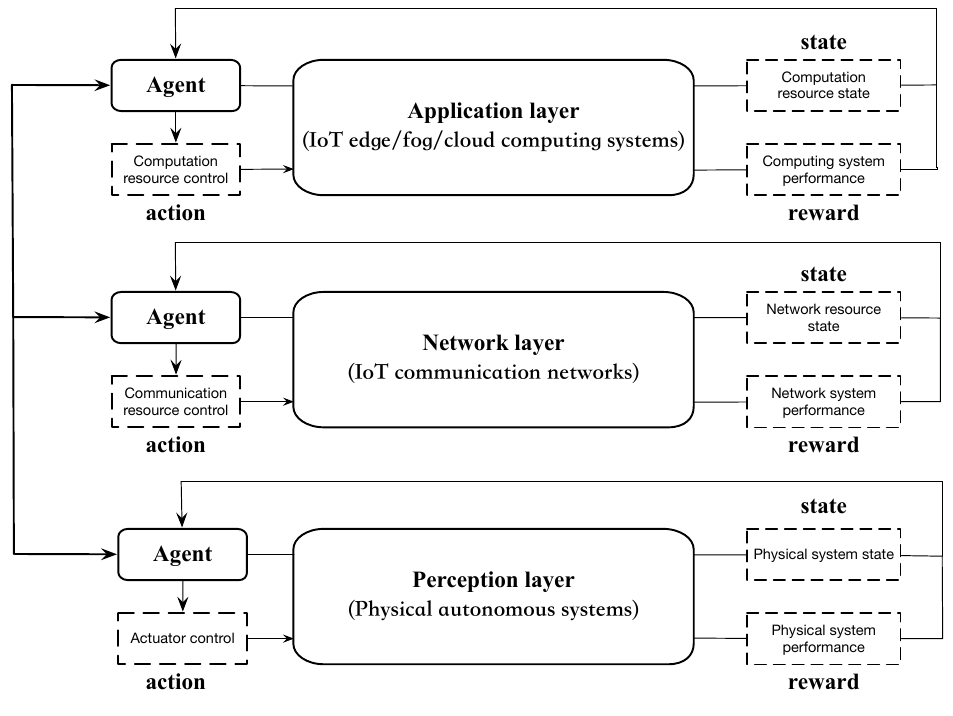
Figure 3. General RL/DRL model for autonomous IoT [71].